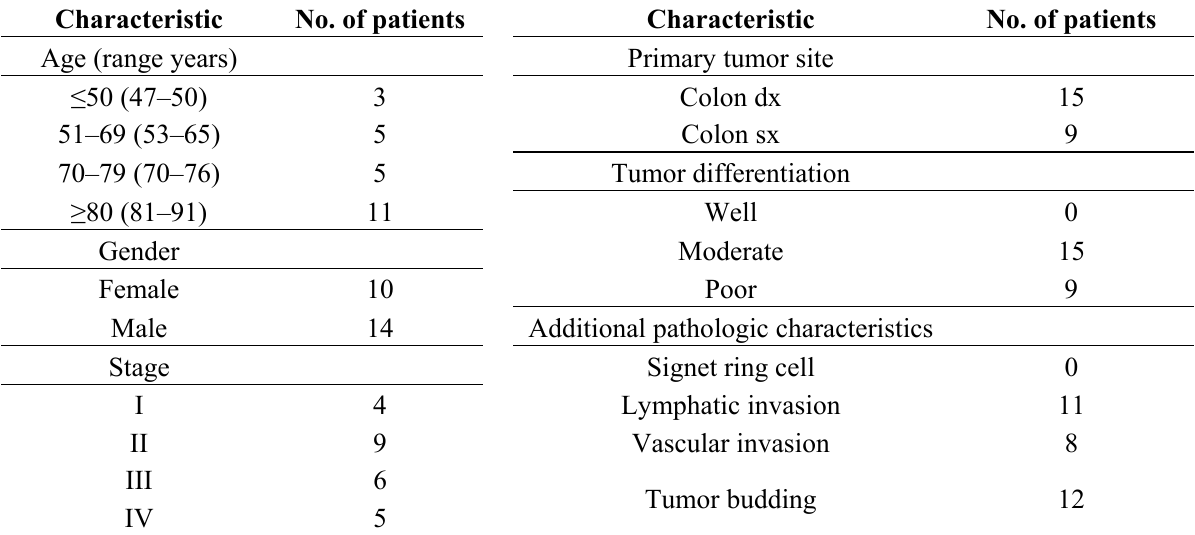
Table 1. Patient and tumor